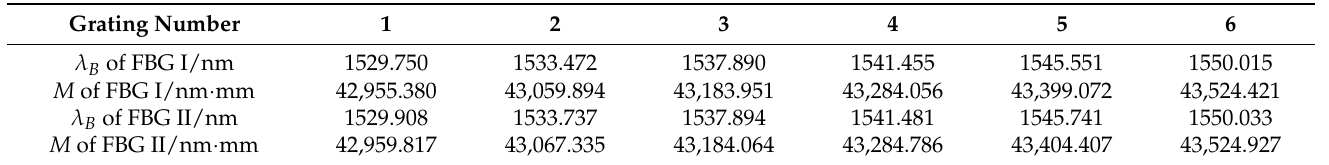
scraper conveyor after packaging.